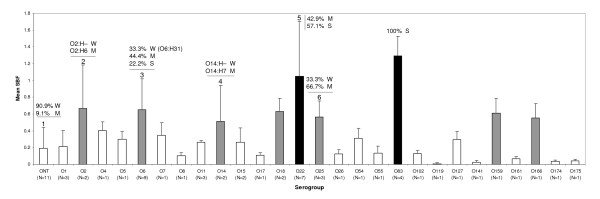
Mean SBF index of the strains classified by their serogroup. White bars: Serogroups with mean SBF that falls into 'weak' biofilm formation category. Grey bars: Serogroups with mean SBF that falls into 'moderate' biofilm formation category. Black bars: Serogroups with mean SBF that falls into 'strong' biofilm formation category. The serotype of those E. coli strains that showed different biofilm formation category than the mean SBF for the serogroup is specified: 1: Only AIEC17 (ONT:HNT) strain was classified as 'moderate' biofilm producer (M). 2: Nonmotile ECG-041 (O2:H-) strain was classified as 'weak' biofilm producer (W). 3: Three strains with O6:H31 serotype were classified as 'weak' biofilm producers, whereas strains with O6:H1, O6:H5 and O6:HNT serotypes were 'moderate' or 'strong' biofilm producers. 4: Nonmotile ECG-054 (O14:H-) was 'weak' biofilm producer (W). 5: Three strains were 'moderate' (O22:H1) and 4 strains 'strong' (O22:H1, O22:H7, and O22:H18) biofilm producers. 6: AIEC08 (O25:H4) was classified as 'weak' biofilm producer.